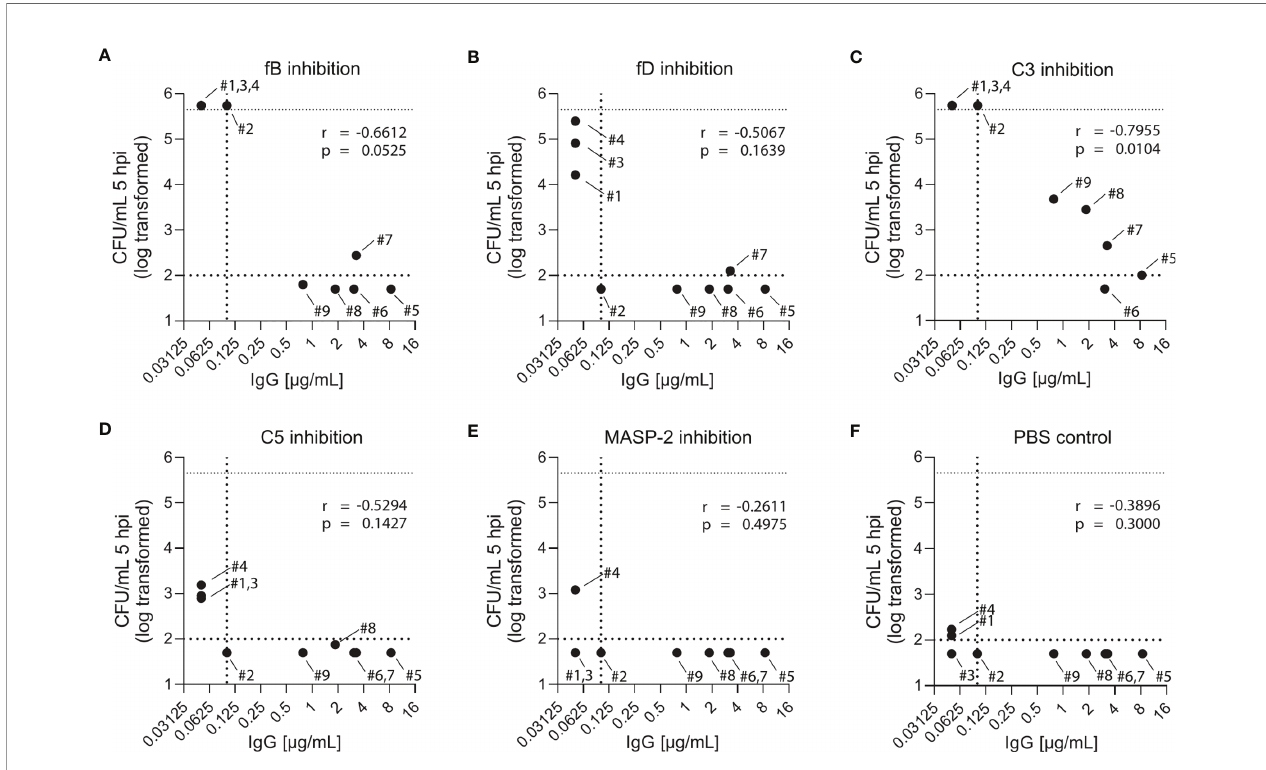
FIGURE 6 | Effect of complement inhibition and anti-pneumococcal capsule antibody concentrations on pneumococcal killing in individual study participants. Pneumococcal killing was assessed in an opsonophagocytosis assay based on DPBS-washed cells from EDTA-anticoagulated blood reconstituted with active serum comparing individual vaccine-naïve and PCV13-vaccinated subjects in the presence of 10µM fB (A) or fD (B) inhibitor, 50 µg/mL C3 (C) , C5 (D) or MASP-2 (E) inhibitor and PBS control (F) . Log- transformed bacterial number in CFU/mL fi ve hours after bacterial inoculation were correlated with capsule-speci fi c IgG concentrations in serum of each individual study participant. Dashed horizontal lines demonstrate the lower detection limit and the upper limit for bacterial quanti fi cation, while the dashed vertical line represents lower limit for IgG concentration quanti fi cation. hpi: hours post